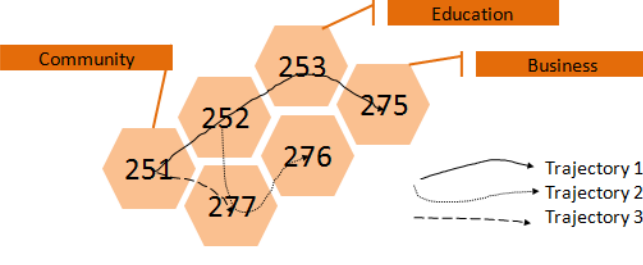
Figure 3. Semantic